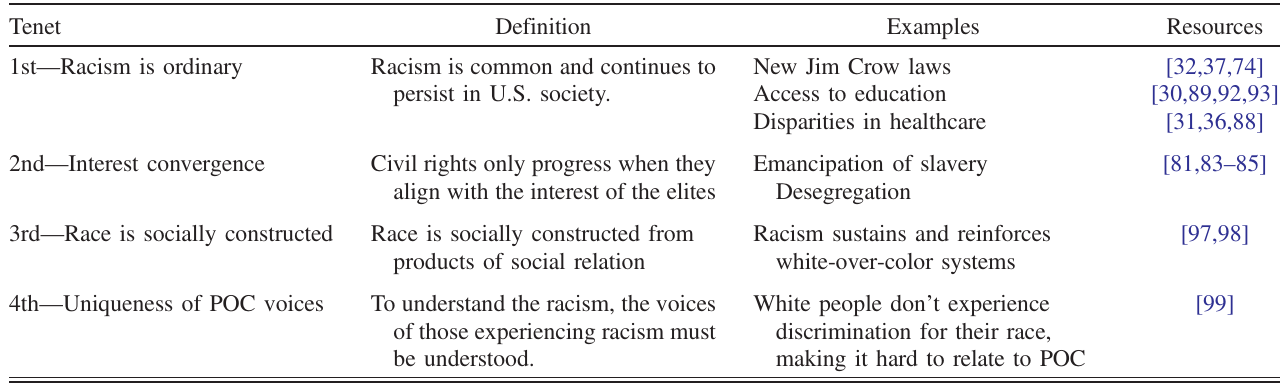
TABLE II. Summary of the four tenets of critical race